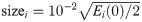
Scatter plot of impact and vulnerability values for each bank in years 2008 (upper panels) and 2013 (lower panels).Here we show the cases of maximal or vanishing strength of liquidity shocks (ρ = 1 or ρ = 0, respectively) and of instantaneous or vanishing damping of shocks (τ = 0 and τ = ∞, respectively). The size of the bubble is non-linearly proportional to the initial equity of the corresponding bank: sizei=10-2Ei(0)/2. The color of the contour is instead given by the value of the generalized leverage λΛi + ρϒi.